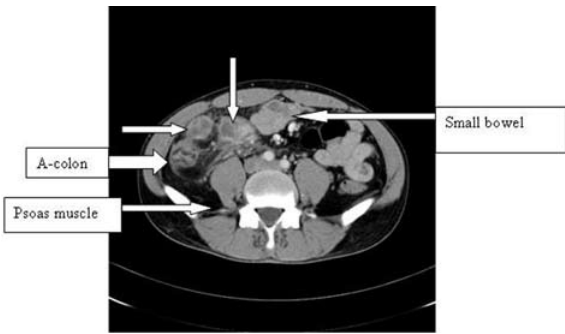
(arrows).Fig. 1. Pre-operative computed tomography scan of the abdomen. The largest abscess is located at the ascending colon mesentery, anterior to the right psoas muscle (vertical arrow). There are several smaller abscesses over the omentum, and paracolic gutter (horizontal